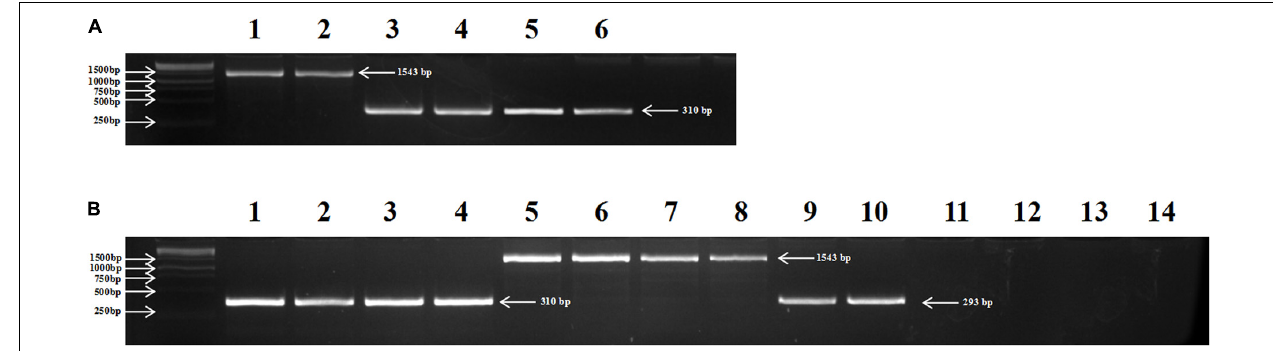
FIGURE 5 | Distribution of TbMYC4A in Z18-1244, Crocus, G52, and 14 examples selected from 7 Triticeae species. (A) lanes 1 and 2: Crocus; lanes 3 and 4: T. boeoticum G52; lanes 5 and 6: Z18-1244; (B) T. monococcum accessions PI 10474T (1) and PI 168805 (2); T. boeoticum accessions PI 401416 (3) and PI